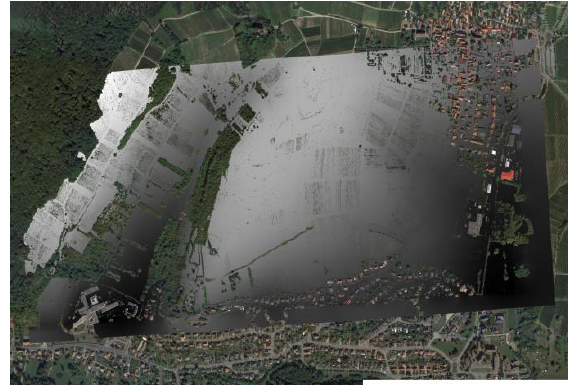
Figure 9. Additional applied filtering of the DTM for closing gaps with SAGA-GIS.